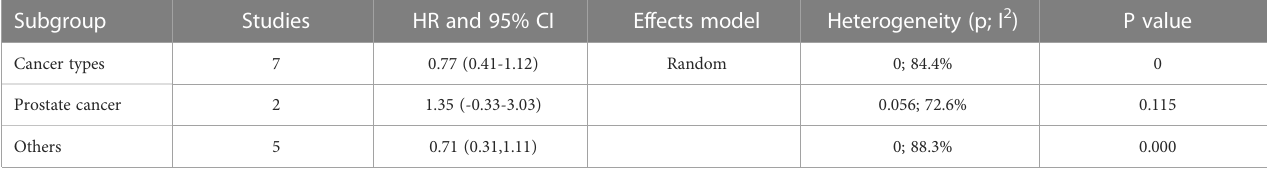
TABLE 4 Subgroup analysis for the relationship between high ING3 expression and survival of cancer patients. Subgroup